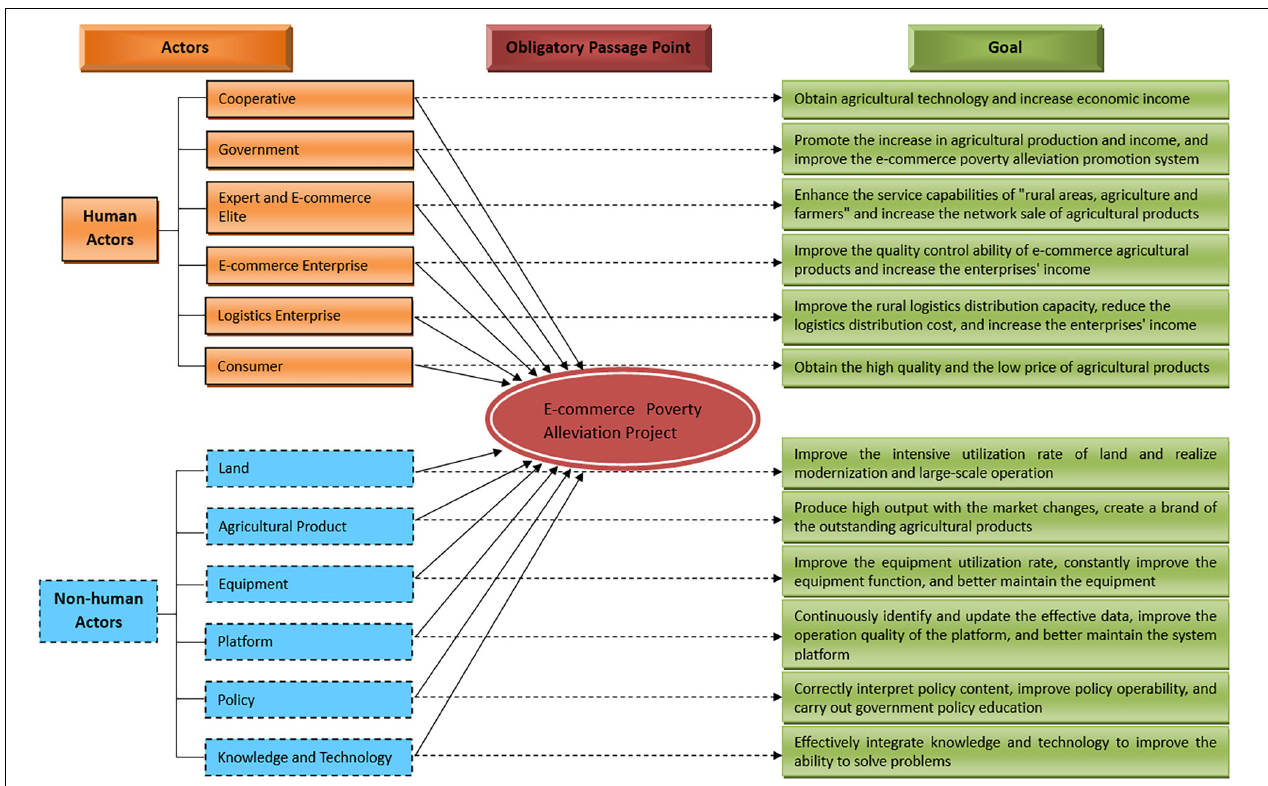
FIGURE 3 | Problematization and obligatory passage point (OPP) of